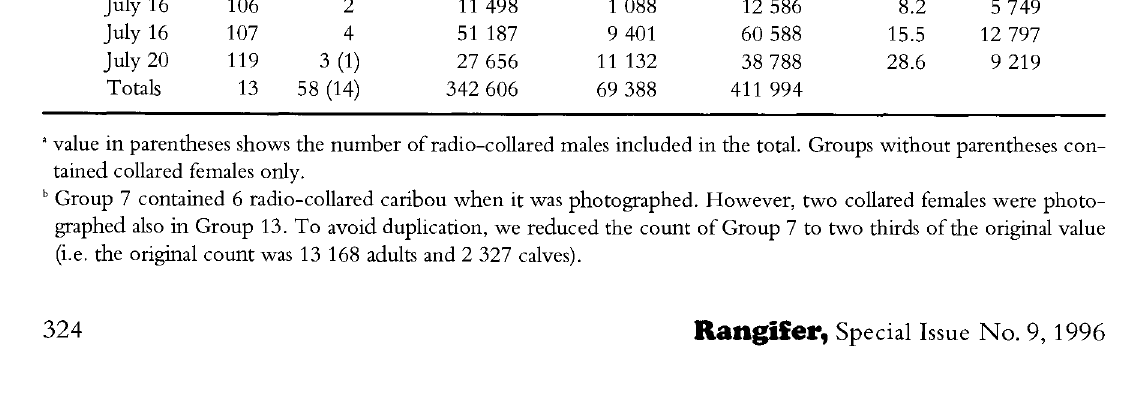
Table 1. Post-calving aggregations of the Rivière George herd photographed between 4 - 23 July 1993 and used in the calculation of population